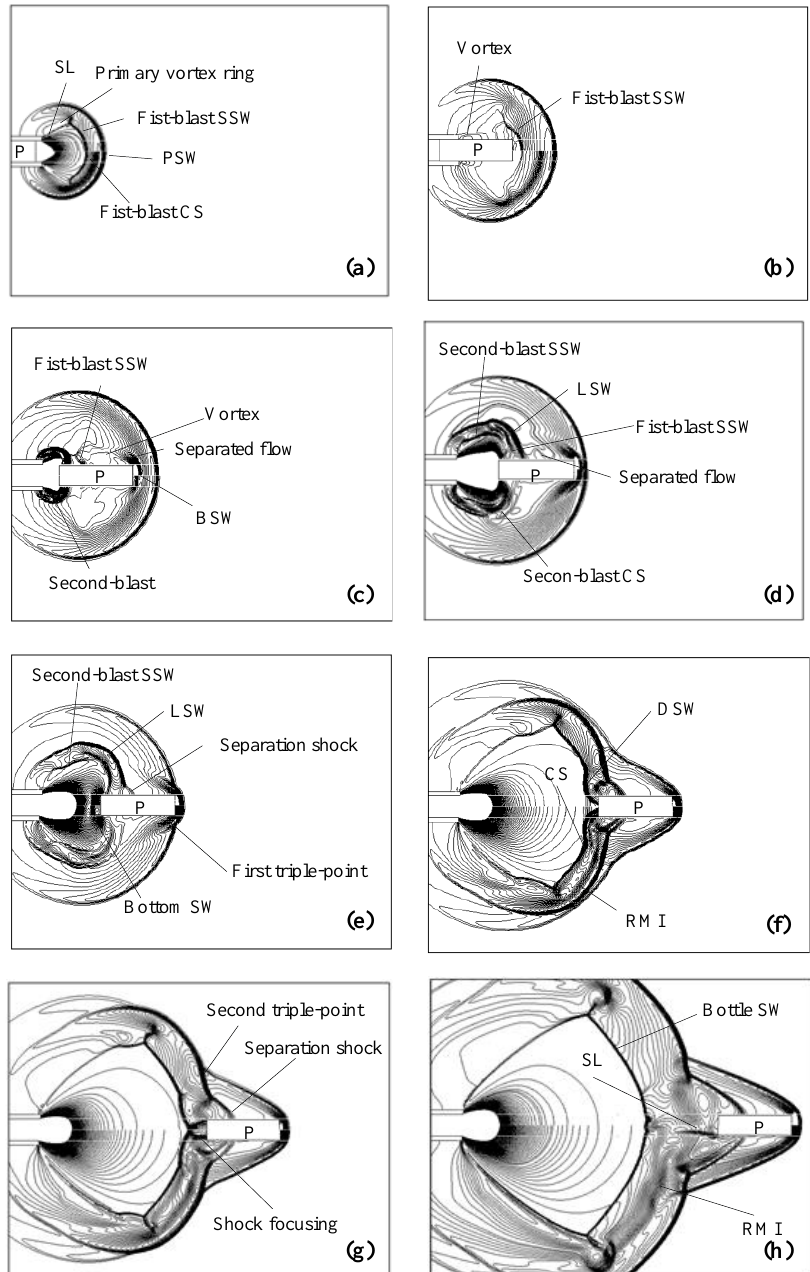
Figure 7. Isopycnic (the lower half) and isobars(the upper half) for flat-ended projectile, ( a ) t = 0.271 ms; ( b ) t = 0.472 ms; ( c ) t = 0.590 ms; ( d ) t = 0.671 ms; ( e ) t = 0.736 ms; ( f ) t = 0.989 ms; ( g ) t = 1.091 ms;